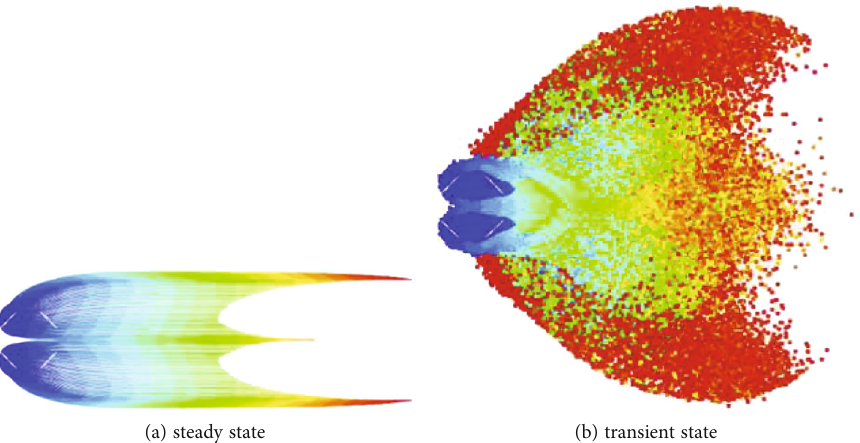
Figure 15: Droplets trajectory of a quadrotor model when the free stream velocity is 3 m/s.